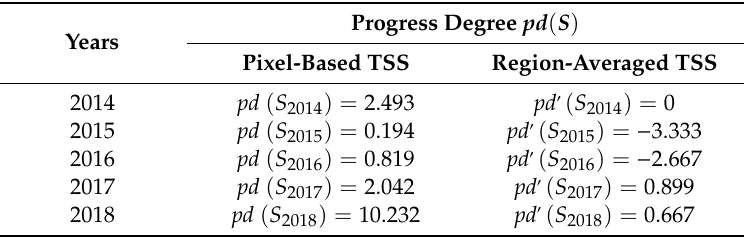
Table 5. Taking Shijiao Town of Hedi Reservoir as the research area, Markov evaluation was performed on the water quality using the pixel-based TSS and regional-averaged TSS